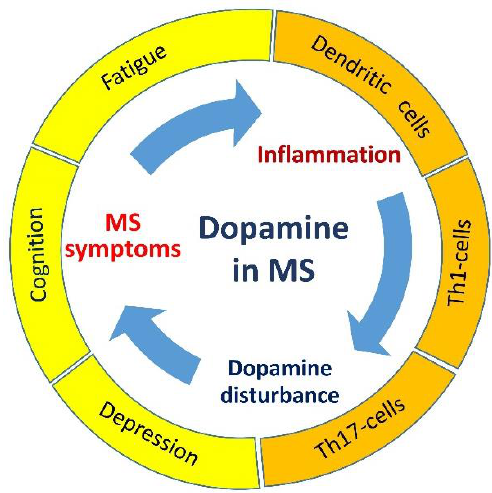
Figure 1. The possible role of dopamine in the development of clinical symptoms and autoimmune inflammation in MS. The dopaminergic system disturbance causes MS neuropsychological symptoms, which may aggravate MS course by the induction of pro-inflammatory cytokine production. MS exacerbation may induce a disturbance of dopamine metabolism and increase neuropsychological symptom severity.